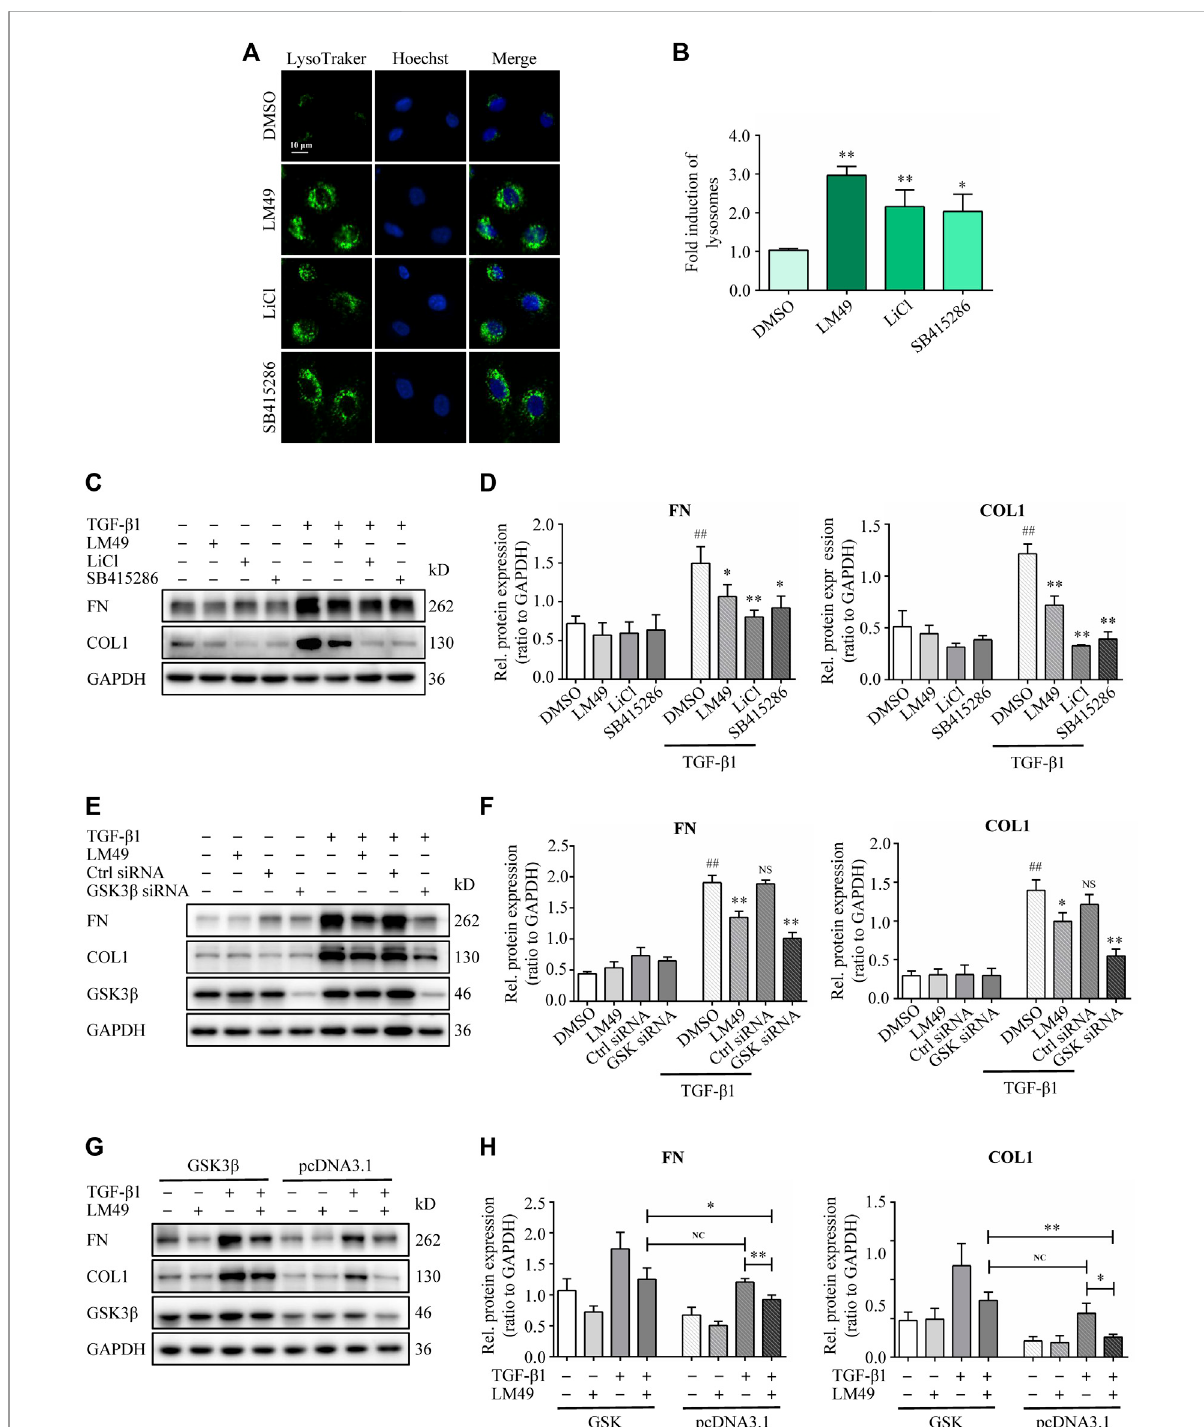
FIGURE 6 LM49 actsthroughGSK3 β toinduce ECMproteindegradation. (A) LysoTrackerGreen staininginNRK49F cellstreatedwith LM49 (20 μ M,24 h), LiCl (10 mM 24 h) and SB415286 (20 μ M, 24 h). (Scale bar, 10 μ m). (B) Quanti fi cation of LysoTracker Green intensity of (A) . * p < 0.05, ** p < 0.01 compared with DMSO group (n = 3). (C) Immunoblot analysis of the protein expression of FN and COL1 in NRK49F cells treated with LM49 (20 μ M),LiCl(10 mM),orSB415286(20 μ M)intheabsenceorpresenceofTGF- β 1(5 ng/ml)for24 h. (D) Quanti fi cationofFNandCOL1intensity in (C) . ## p < 0.01 compared with DMSO group, * p < 0.05, ** p < 0.01 compared with TGF- β 1 group (n = 3). (E) Immunoblot analysis of the protein expression of FN and COL1 in DMSO-treated or LM49 (20 μ M)-treated NRK49F cells transfected with Ctrl siRNA or GSK3 β siRNA in the absence or